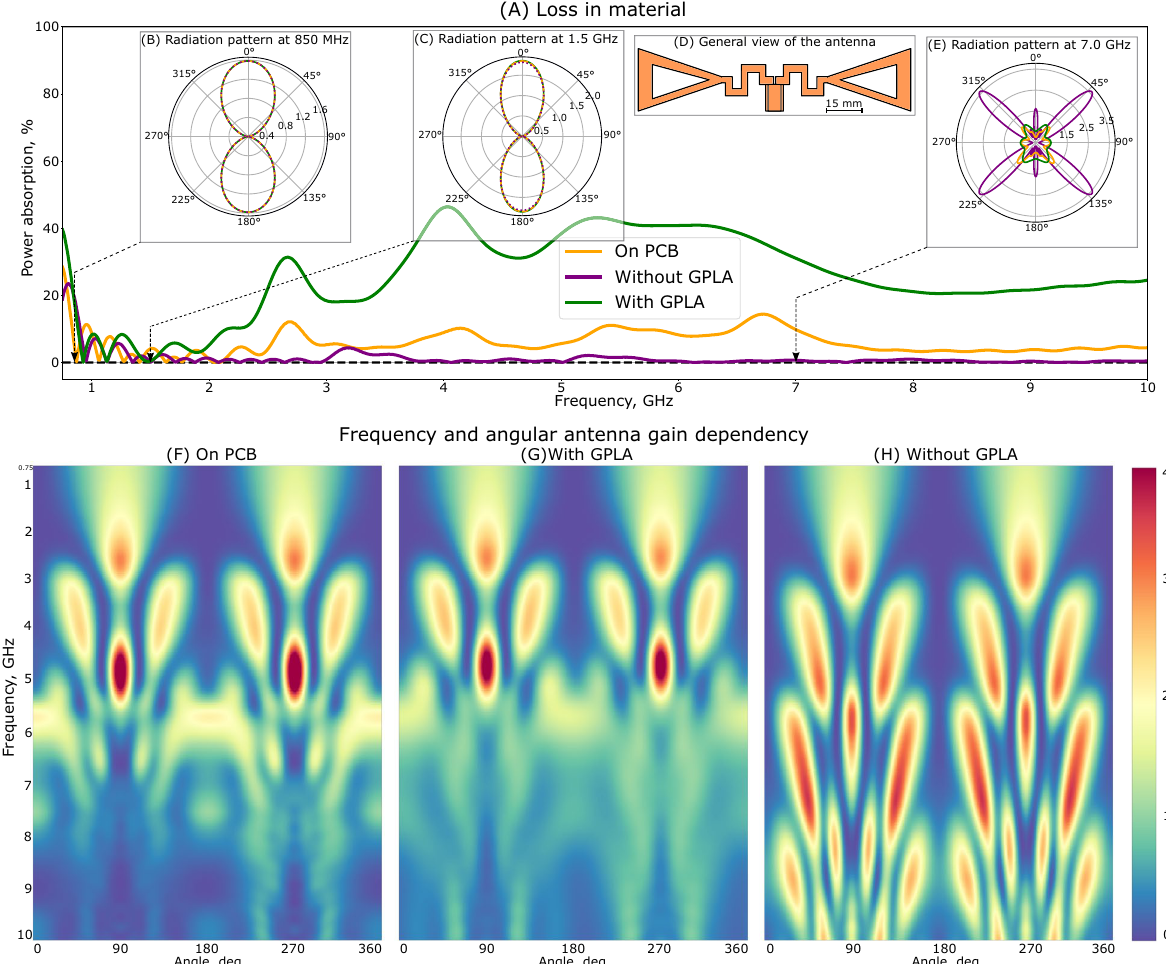
Figure 2. Numerical comparison between 2 antennas—with and without GPLA substrate. ( A ) Normalized absorbed power within the device (in %)—green line—with GPLA, purple—without GPLA. ( B ), ( C ) and ( E ) Radiation patterns at 850 MHz, 1.5 GHz and 7 GHz, respectively. ( D ) Antenna layout. ( F ), ( G ) and ( H ) Color maps of unwrapped radiation patterns (linear scale). Horizontal and vertical axes—angular and frequency dependences, respectively. Antenna gain is represented by color in linear